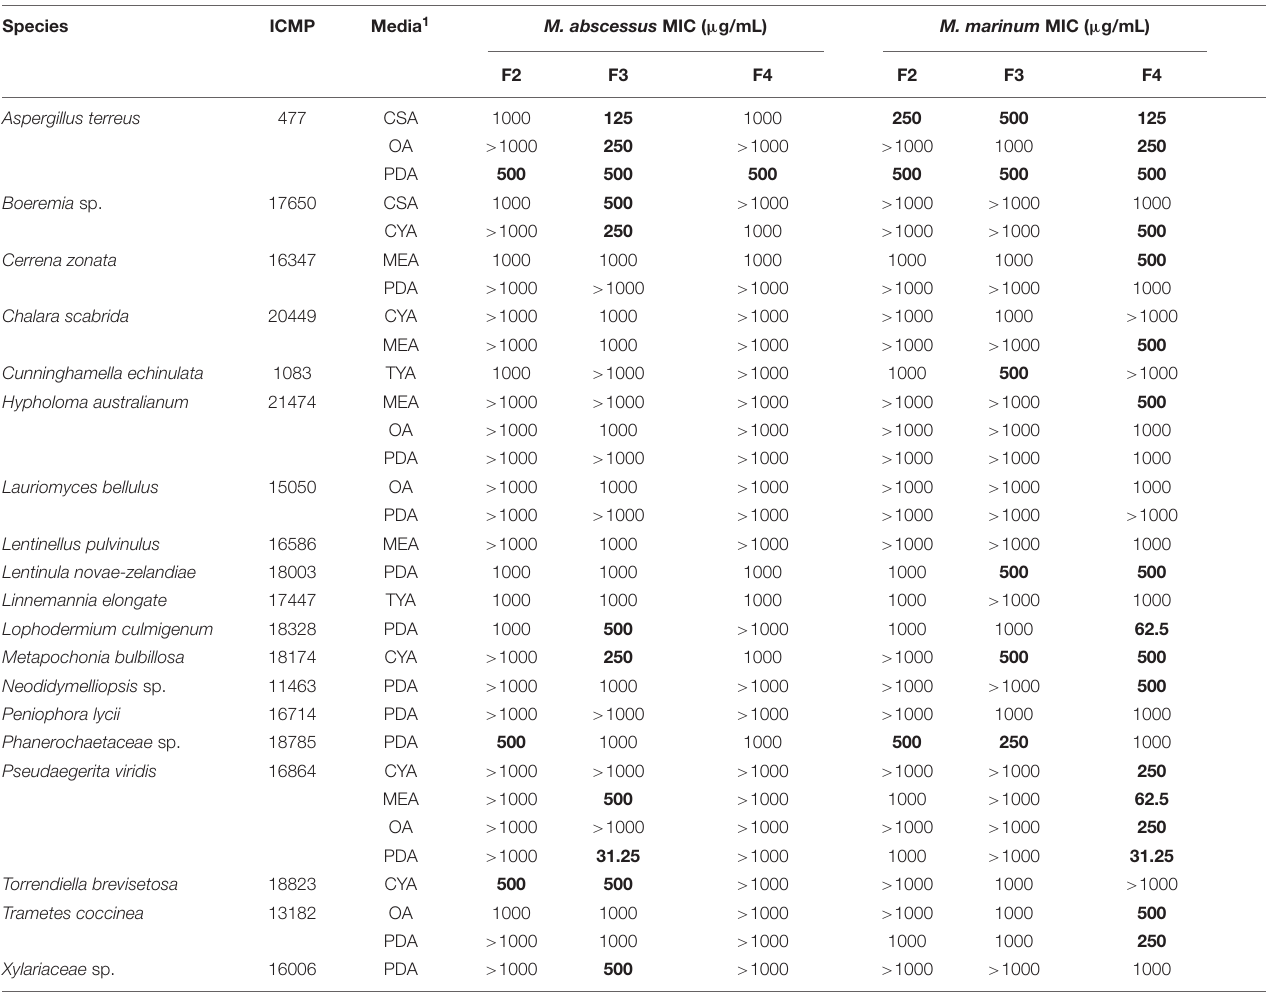
TABLE 4 | Minimum inhibitory concentrations (MIC) of ICMP fungal fractions (F2, F3, and F4) against M. abscessus and M. marinum .